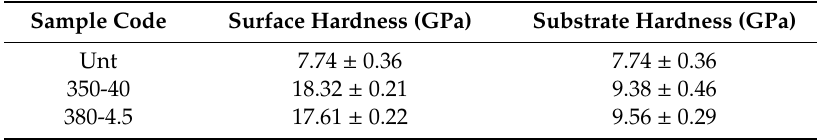
Table 2. Nanoindentation hardness for surface and substrate before and after